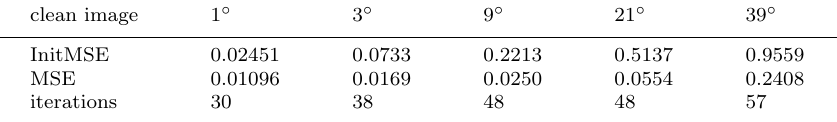
Table 1. Orientation refinement results for the simulated cryo-EM SPM particle images. clean image